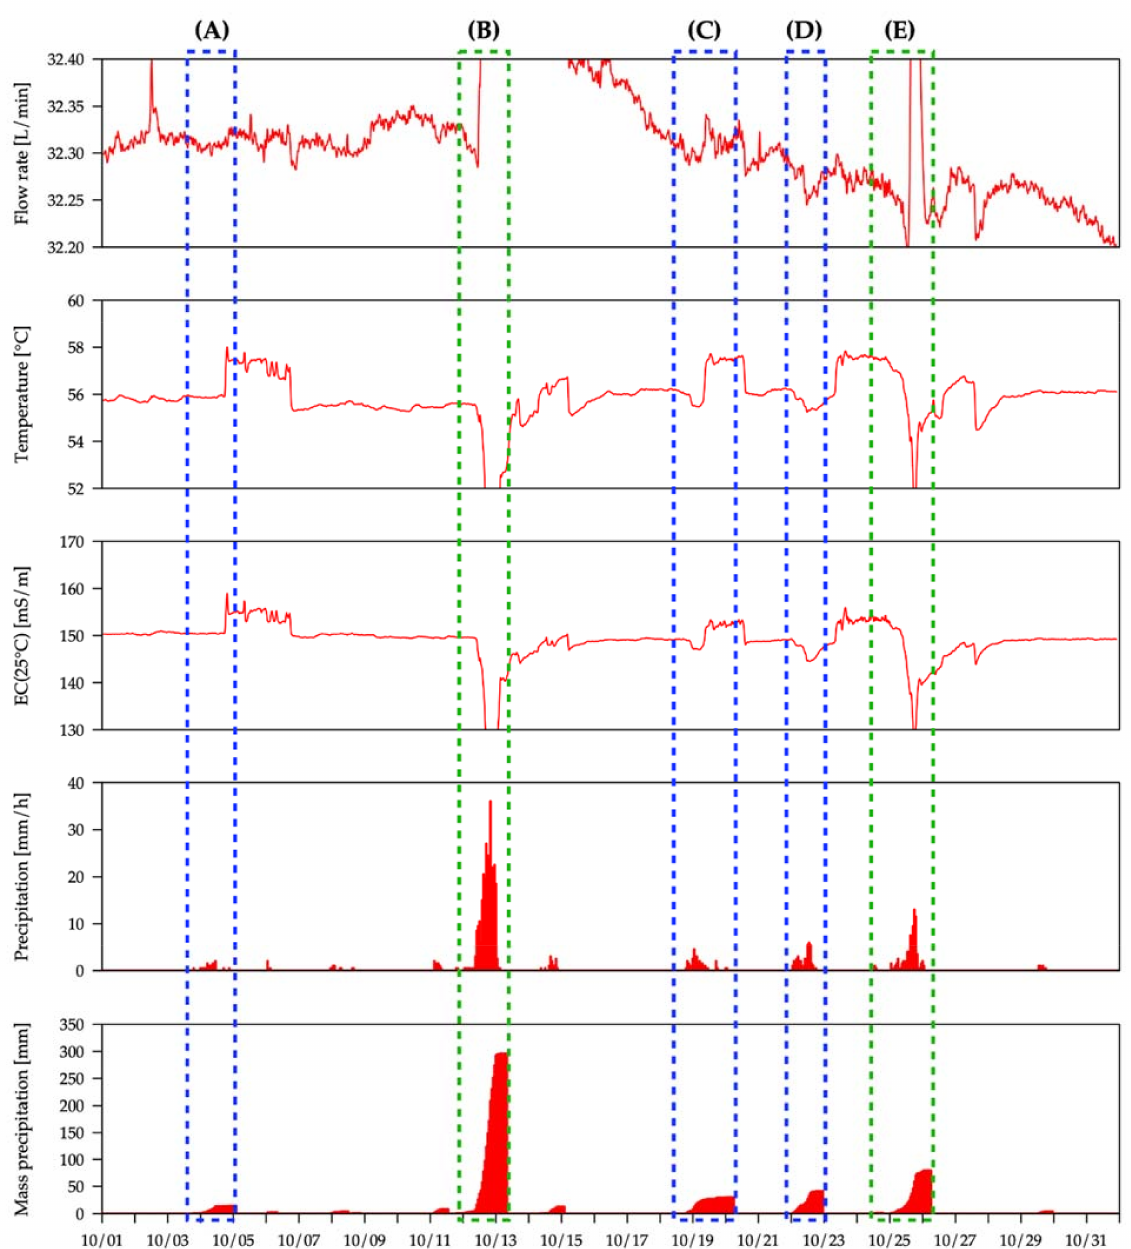
Figure 5. Flow rate, temperature, and EC of the Futamata hot spring measured by the monitoring device. Precipitation around the study area was measured at the AMeDAS Yumoto site. Flow rate, temperature, and EC show the moving average for 1 h. Precipitation indicates the total amount of rainfall observed 1 h before the measurement time. Mass precipitation is the total value of precipitation from the start of rainfall to the time of measurement, which is reset to zero when the no-precipitation period reaches 6 h. ( A – E ) indicates major precipitation events observed in October 2019, respectively (Table